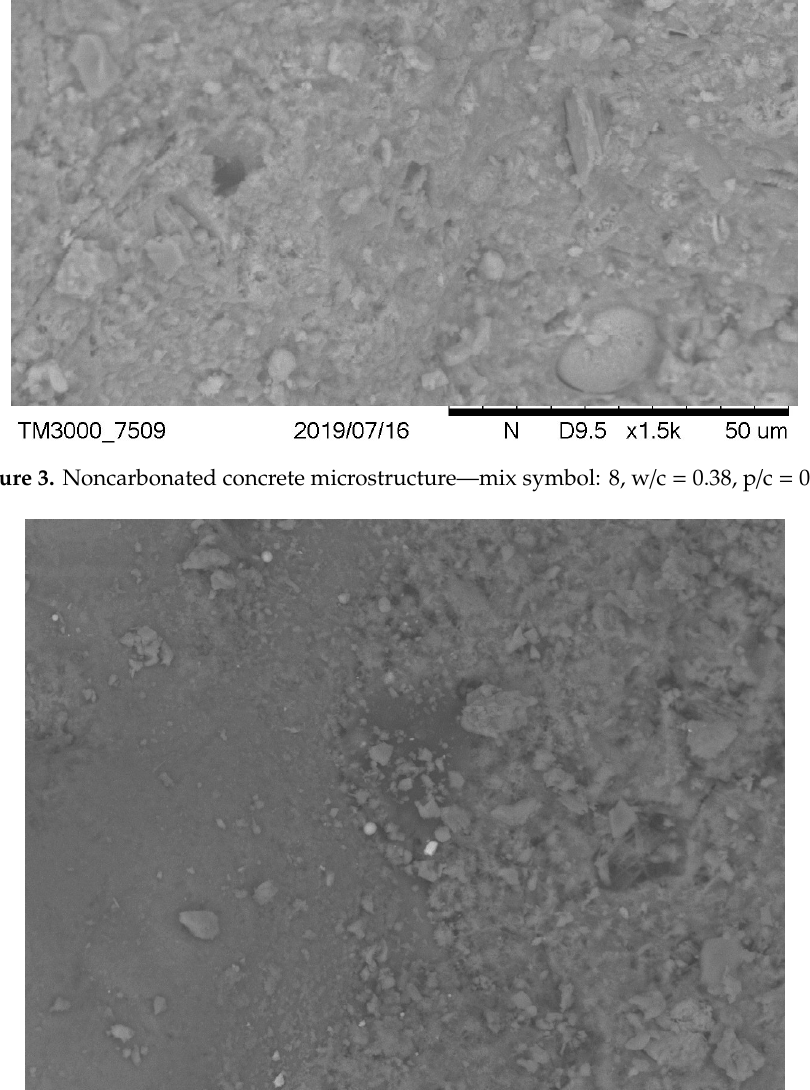
Figure 4. Noncarbonated concrete microstructure — mix symbol: 2, w/c = 0.52, p/c = 0.46.